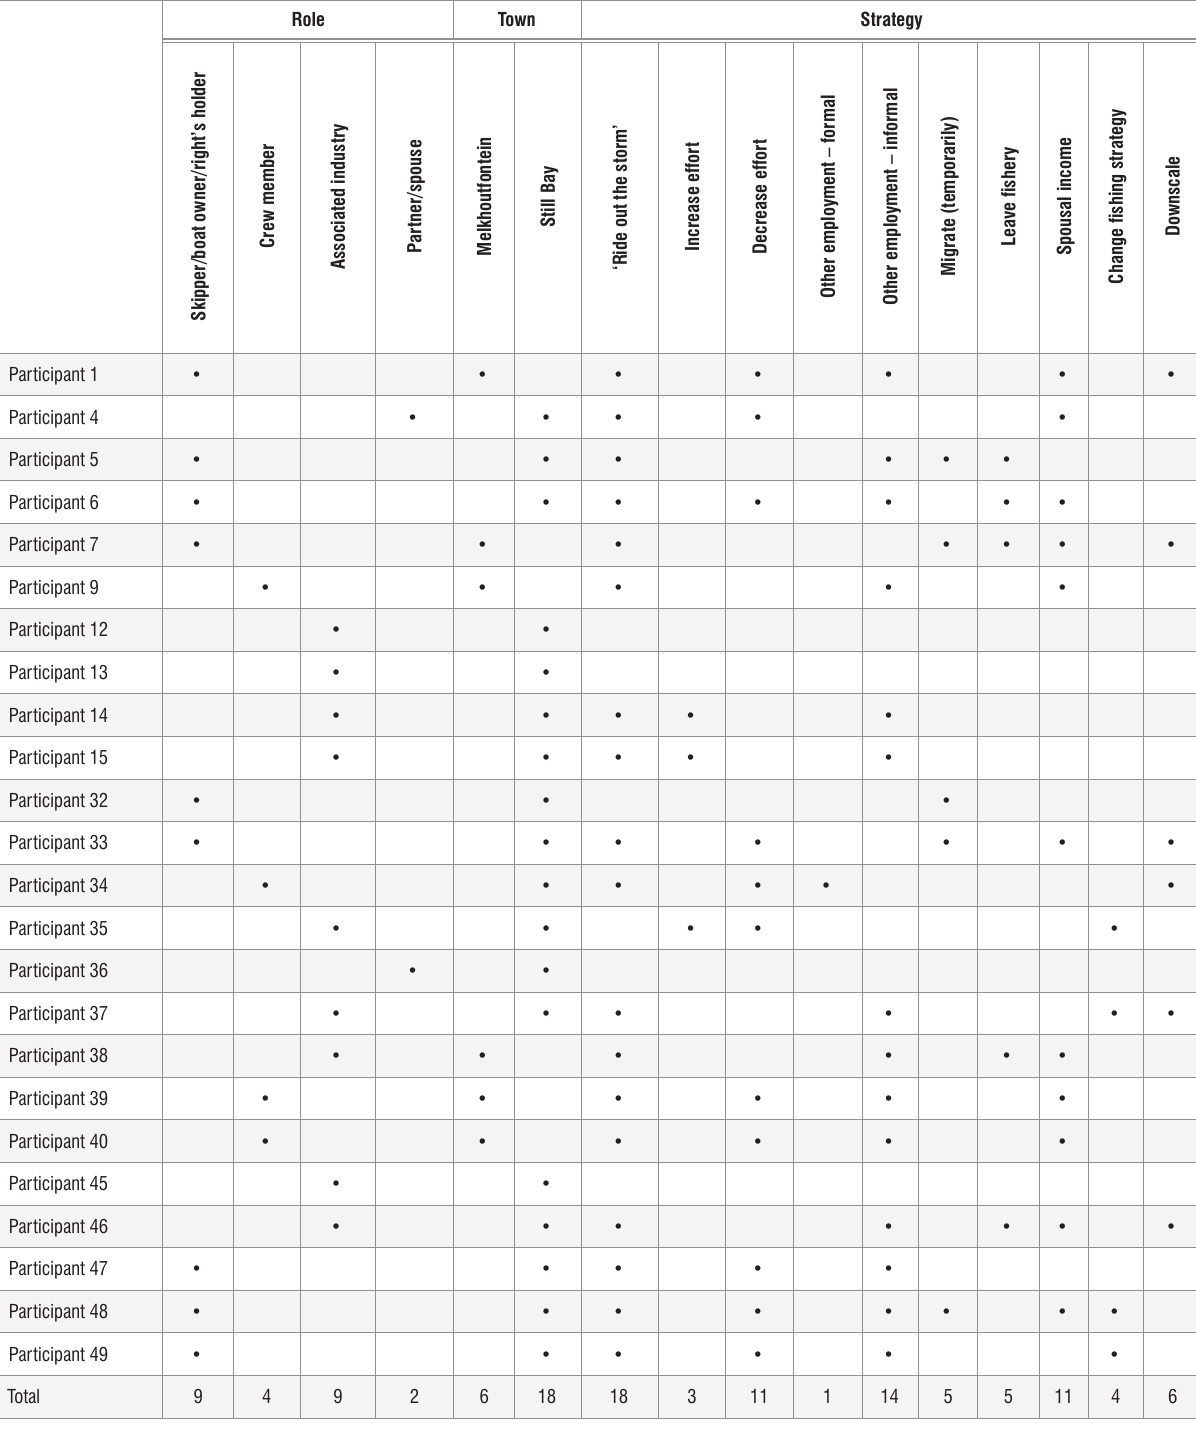
Table 4: Change responses implemented by the fishers from Still Bay and Melkhoutfontein: coping fishers Role Town